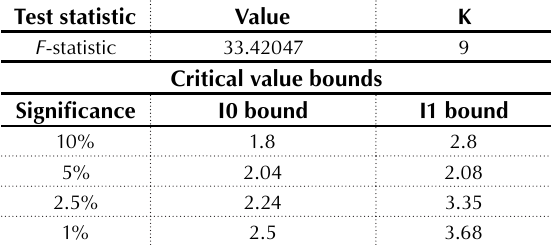
Table 16. ARDL bound test for fiscal behavior Null hypothesis: no long-run relationships exist.